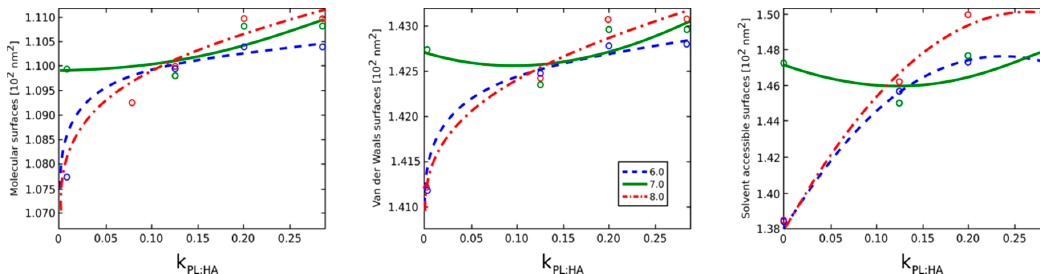
Figure 10. Molecular, van der Waals, and solvent-accessible surfaces as a function of pH values and DPPC concentration. The legend indicates pH values.